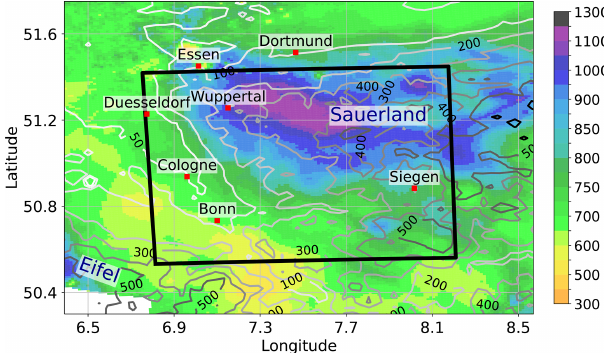
Figure 2. Average yearly precipitation (colors, mmyr − 1 ) from 2001–2021 compiled from the RW product (rain-gauge-adjusted hourly precipitation) of the RADKLIM dataset (see Sect. 2.2). The lateral boundary of the target region is highlighted by the black box. Contour lines show the surface elevation retrieved from the SRTM dataset (NASA JPL,